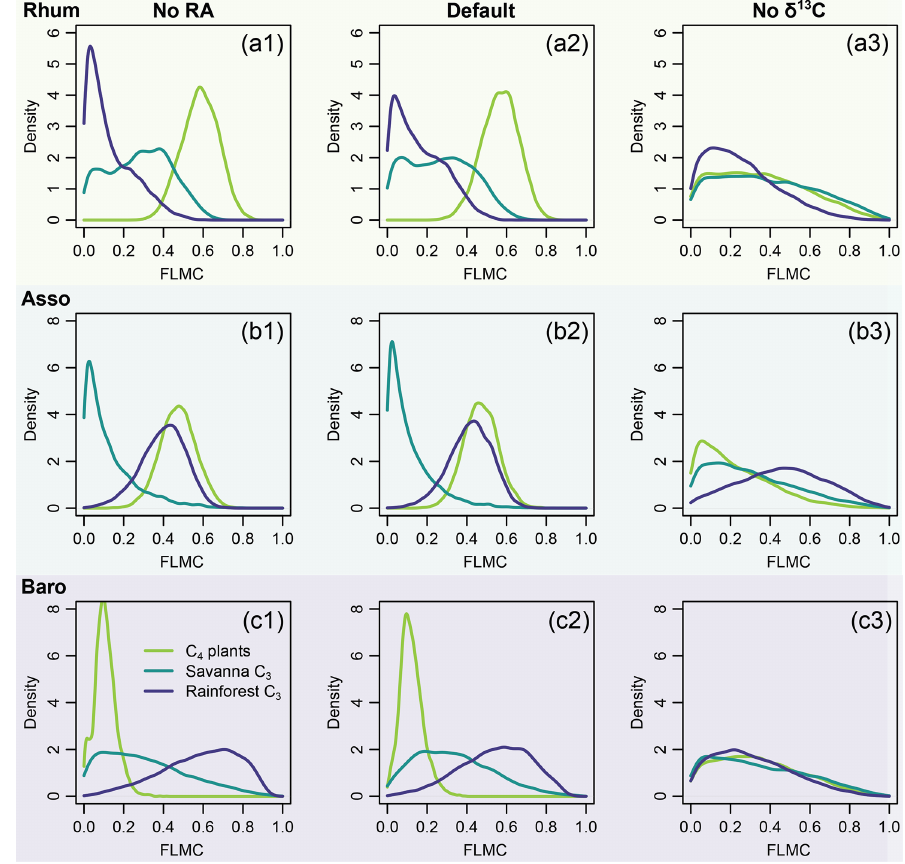
Figure 14. Model sensitivity to proxy type in model inversion (Eqs. 6 and 8), using case study 2 as an example. The right column (No RA) shows the model output with the likelihood evaluations of RA completely removed from model evaluation. The left column (No δ 13 C) shows the model output with the likelihood evaluations of δ 13 C completely removed from model